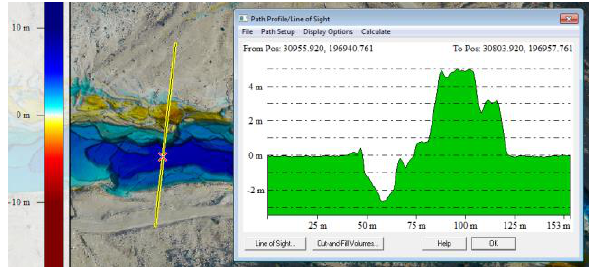
Figure 6. Detail with cross section of the DTM difference.